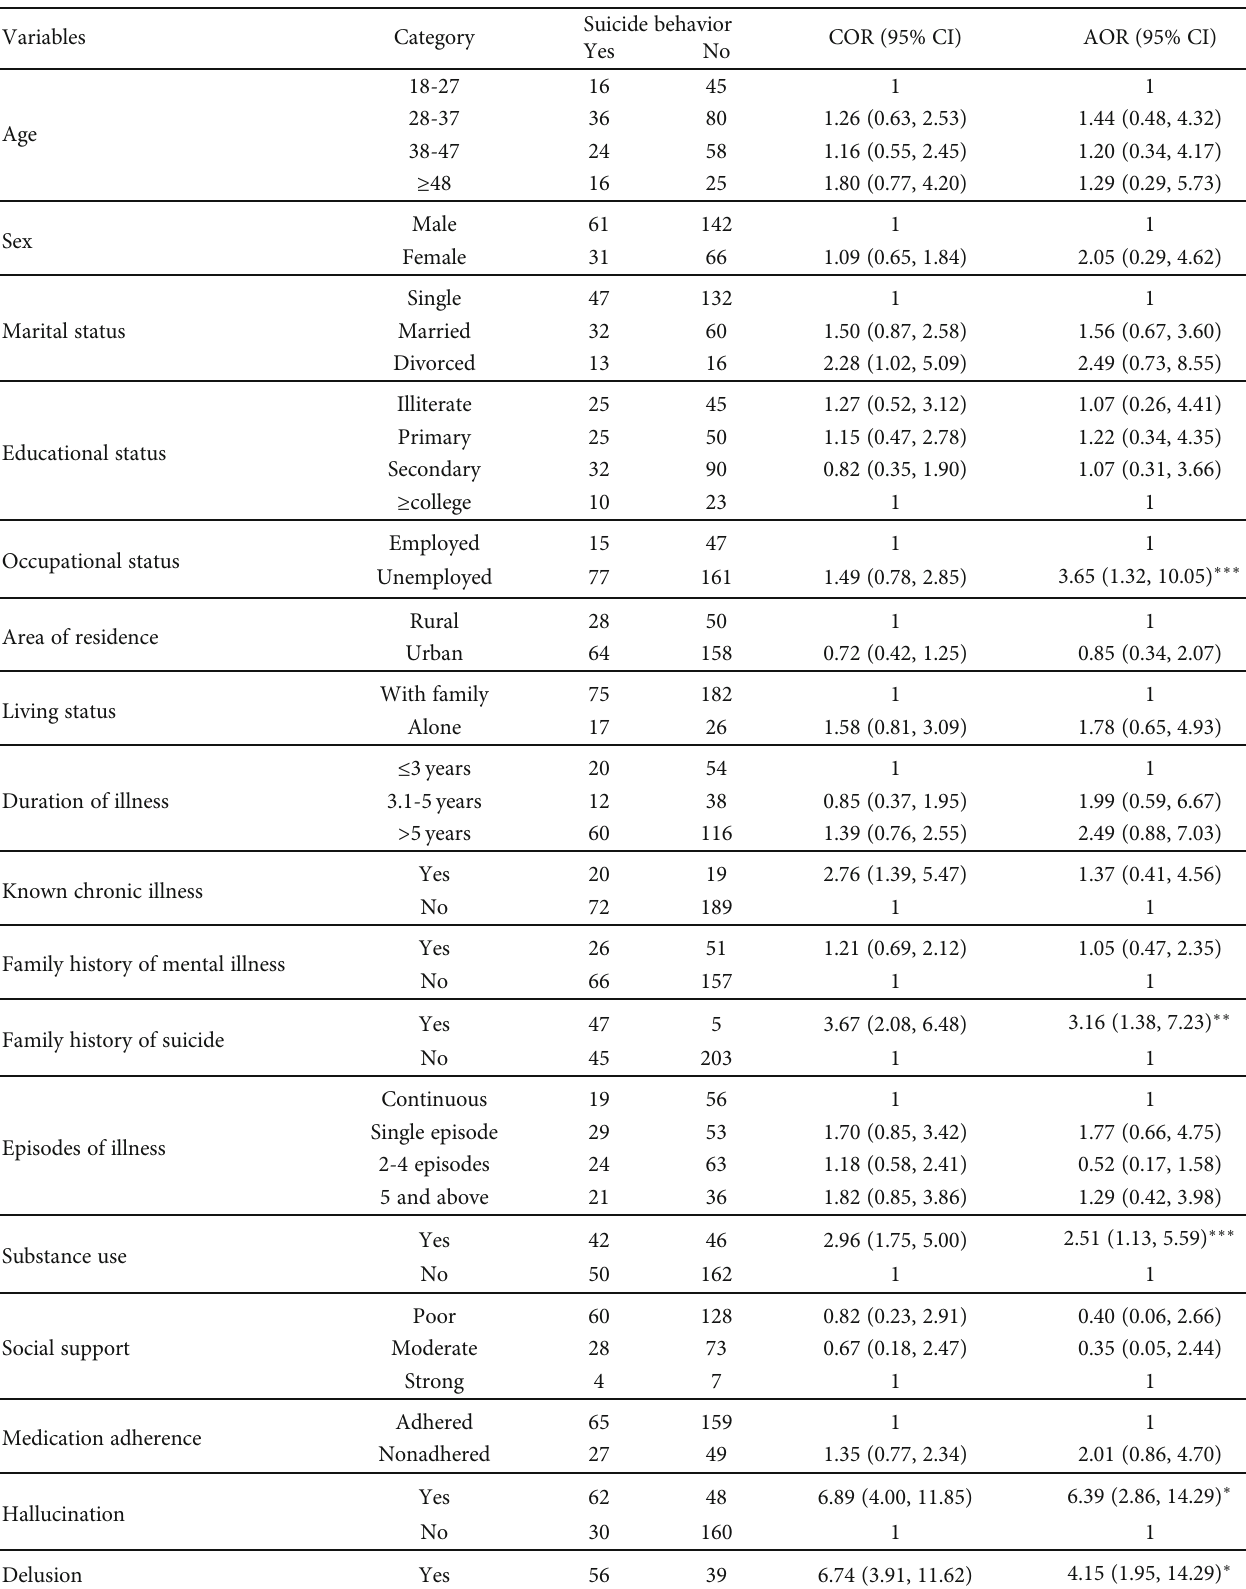
Table 4: Bivariate and multivariate analyses for determinant factors of suicide behavior in patients with schizophrenia at AMSH, Addis Ababa, Ethiopia, 2019 ð N = 300 Þ